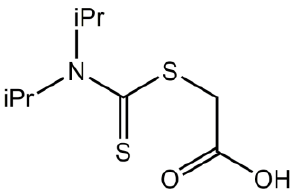
Figure 1. Chemical diagram for 2-{[bis(propan-2-yl)carbamothioyl]sulfanyl}acetic acid ( 1 ).